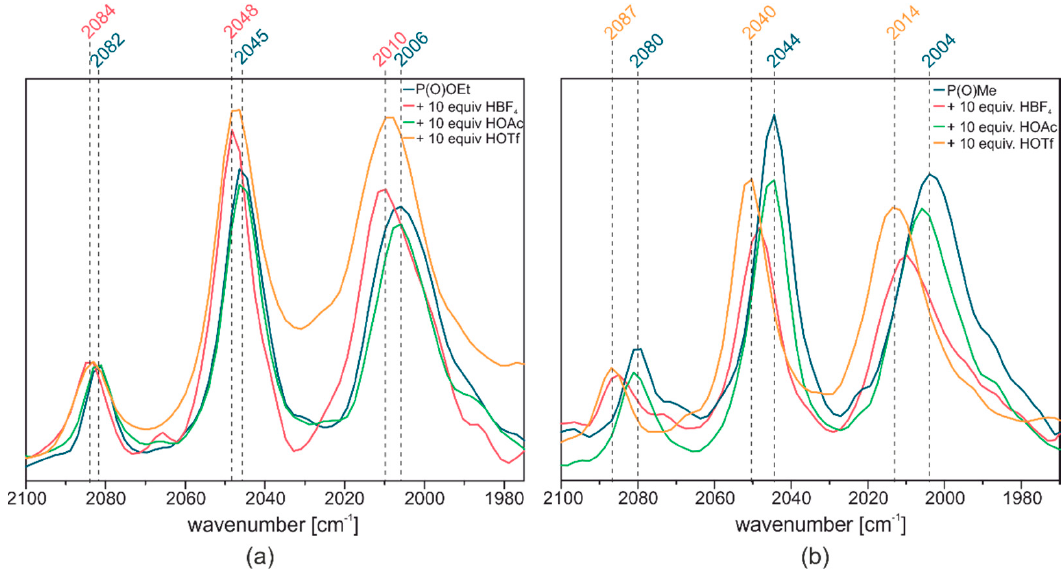
Figure 8. ( a ) IR spectrum of [Fe 2 (CO) 6 ][( μ -SCH 2 ) 2 P(O)OEt]; ( b ) IR spectrum of [Fe 2 (CO) 6 ][( μ - SCH 2 ) 2 P(O)Me]. Both compounds were measured as 20 mM solution in acetonitrile in absence (blue) or presence of acids of different strengths (red: HBF 4 , green: HOAc, yellow: